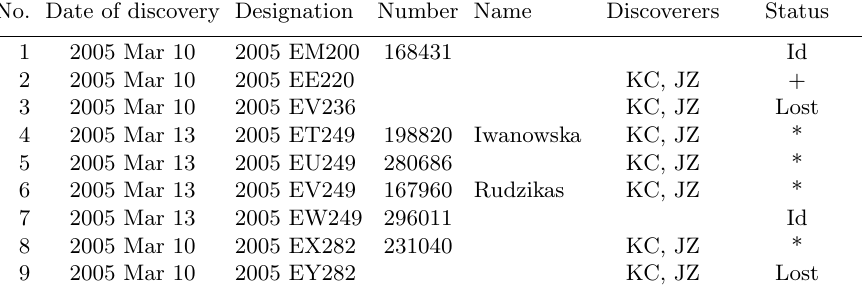
Table 2. List of asteroids discovered at the Mol_etai Observatory in 2005{2007. No. Date of discovery Designation Number Name Discoverers